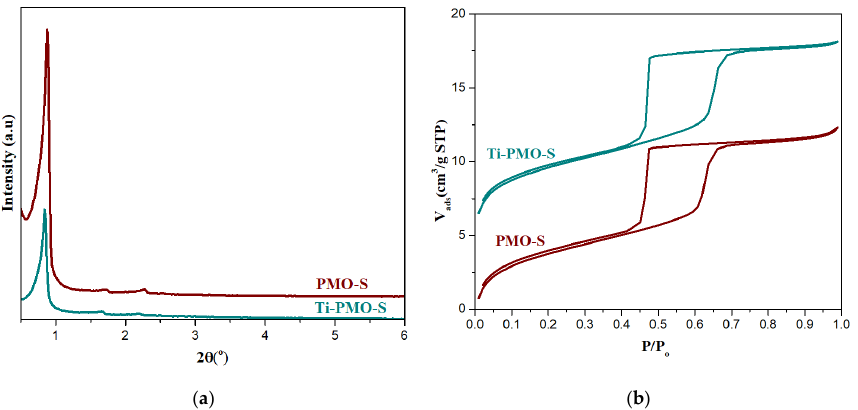
Figure 6. ( a ) Low angle XRD patterns; ( b ) N 2 adsorption-desorption isotherms of PMO-S and Ti-PMO-S materials.